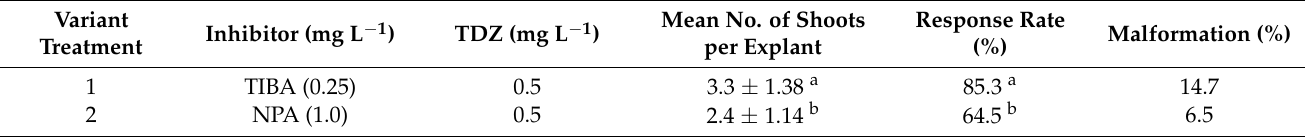
Table 6. Effect of different treatment variant (inhibitors, TDZ concentration) on shoot regeneration and malformation rate (%) of initial explants of C. sativa var. Diana.